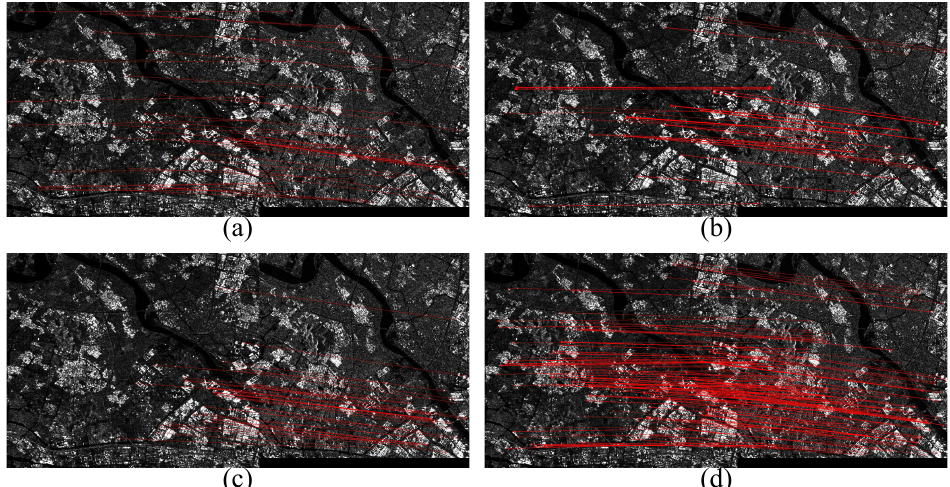
Figure 16. The feature descriptor matching results with different methods for pair 5. ( a ) SAR-SIFT.